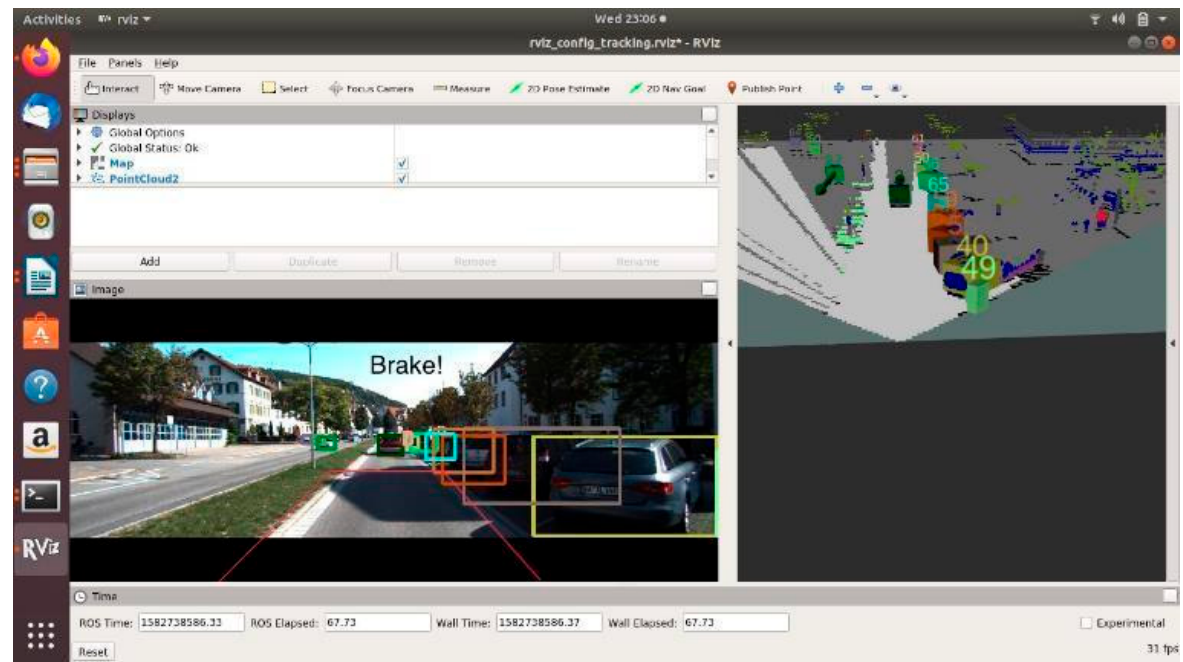
Figure 18. Unsafe scenario for EBA.